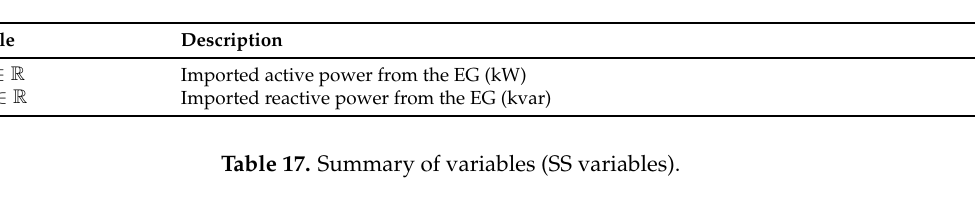
Table 16. Summary of variables (EG variables).